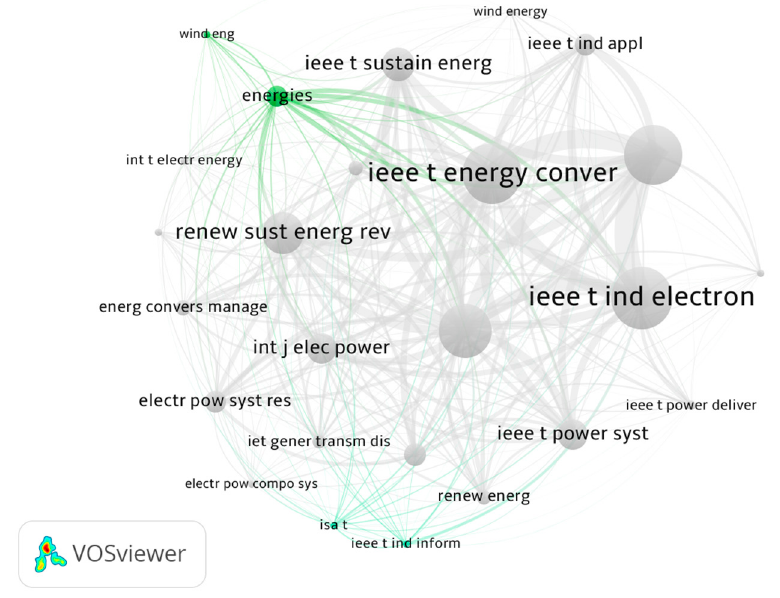
Figure 12. Co-citation map with the most cited journals regarding FRT in PMSG WTGs.